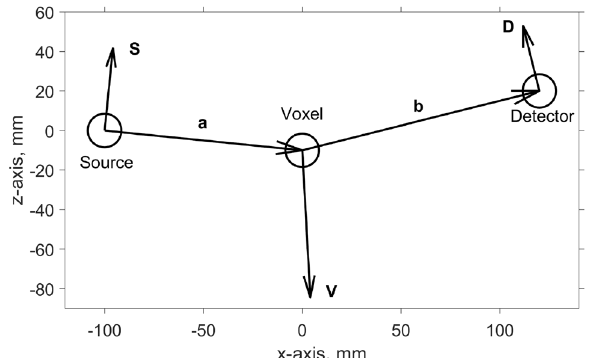
b wave vectors. For the sake of a and outgoing ˆ ˆ